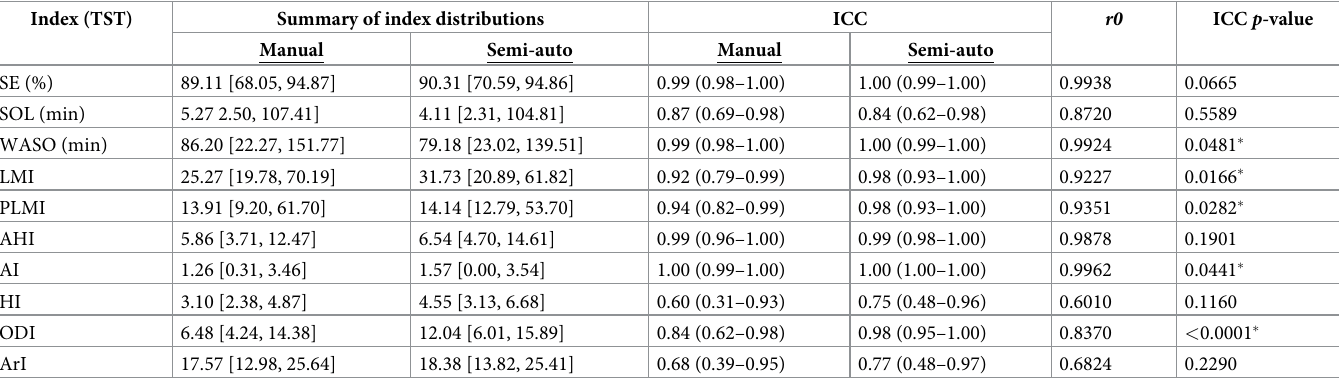
Table 4. Comparison of inter-scoring agreement among diagnostic indices between manual and semi-automatic